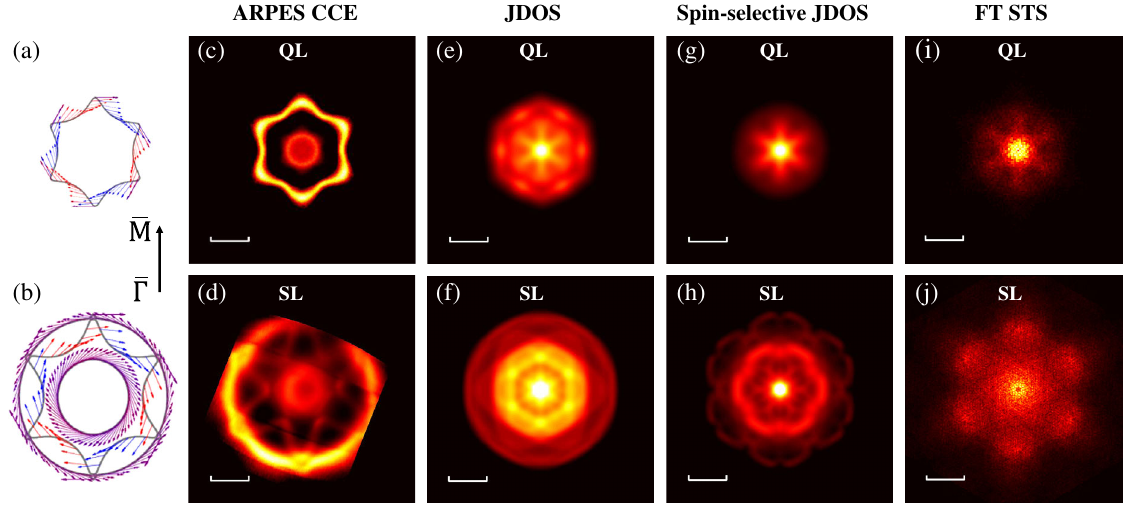
FIG. 3. ARPES contours of constant energy, JDOS, and spin-selective JDOS calculated from ARPES data and FT STS maps at − 50 meV of the two terminations. (a) and (b) are the schematics of the spin texture derived from the k · p Hamiltonian for the QL (a) and SL (b) terminations. Arrows and colors of the vectors represent the in-plane (purple) and out-of-plane (red, þ z ; blue, − z ) components of ¯ Γ − ¯ M spin at the contour maps of the Fermi energy, respectively. The black arrow indicates the direction for all the maps. For QL termination, the hexagonal warping effect causes a canted spin at the z direction. For SL termination, a pair of Rashba-like splitting bands contribute antiparallel helicity for the inner and outer rings in the CCE map. A strong warping effect is observed as a flower- shaped band in between the rings. (c),(d) CCE maps from ARPES measurements at 50 meV below Fermi level for QL (c) and SL (d) terminations. (e),(f) JDOS calculated from the intensity of the CCE map are shown for QL (e) and SL (f) terminations. For the calculation on the SL, idealized bands with an experimentally determined adjusted intensity ratio are used. The JDOS maps show ¯ Γ − ¯ K unexpected scattering intensity at directions. (g),(h) Taking into account the spin-selective joint density of states, the scattering ¯ Γ − ¯ K maps are (g) for QL and (h) SL terminations. For both simulations, the scattering at directions are greatly suppressed. (i) and (j) ¼ − 50 mV, I ¼ 500 pA, image size 100 × 100 nm 2 , showing are the Fourier transformation on the dI=dV maps (FT STS) at V t bias good agreement with the spin-selective JDOS maps. The scale bars are 0 . 1 Å − 1 in CCE maps and 0 . 2 Å − 1 in the rest maps. FT STS maps are rotationally